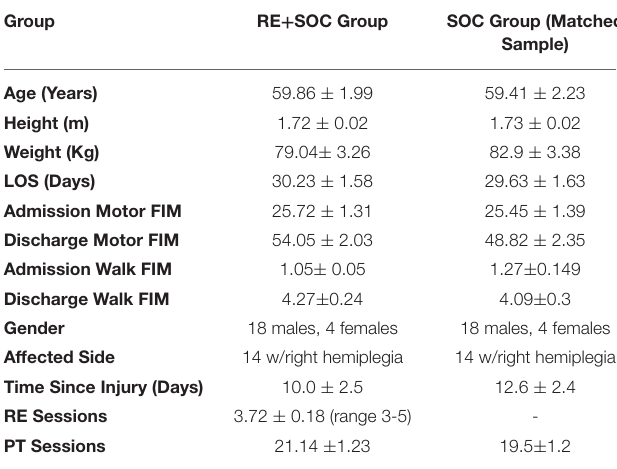
TABLE 1 | Participant demographics (mean ± standard